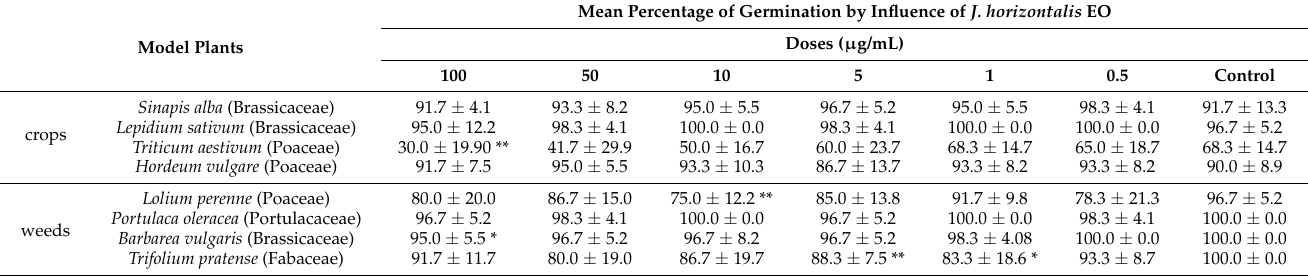
Table 2. Percentage (%) of germinated seeds after 120 h from the application of several doses of J. horizontalis EO. Results are reported as the mean ± SD of six experiments. Mean Percentage of Germination by Influence of J. horizontalis EO Doses ( µ g/mL) Model Plants 100 Control